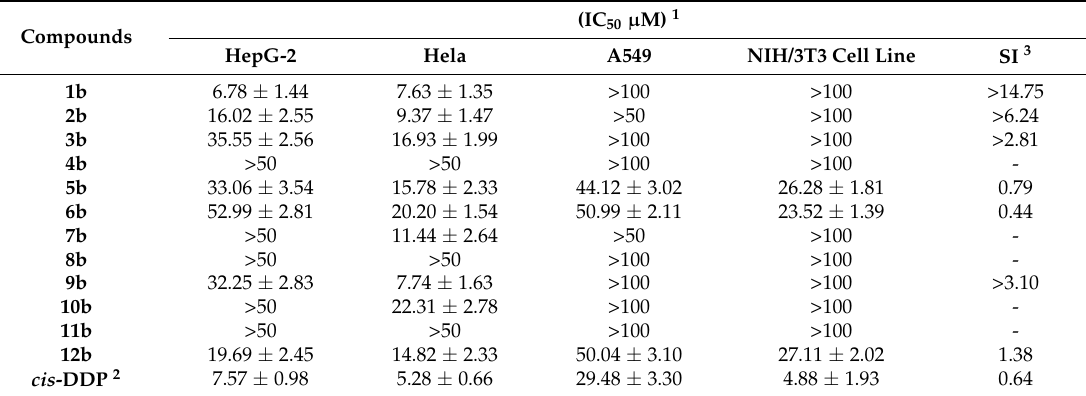
Table 2. Antiproliferative activity of the synthesized compounds (IC 50 µ